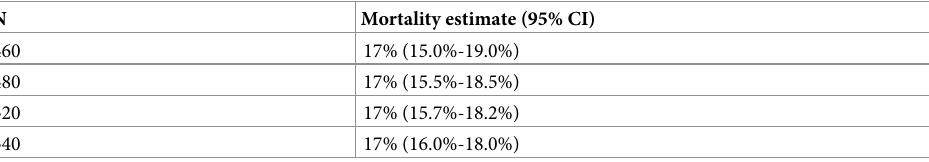
Table 1. Simulated samples sizes around the departmental cumulative neonatal mortality